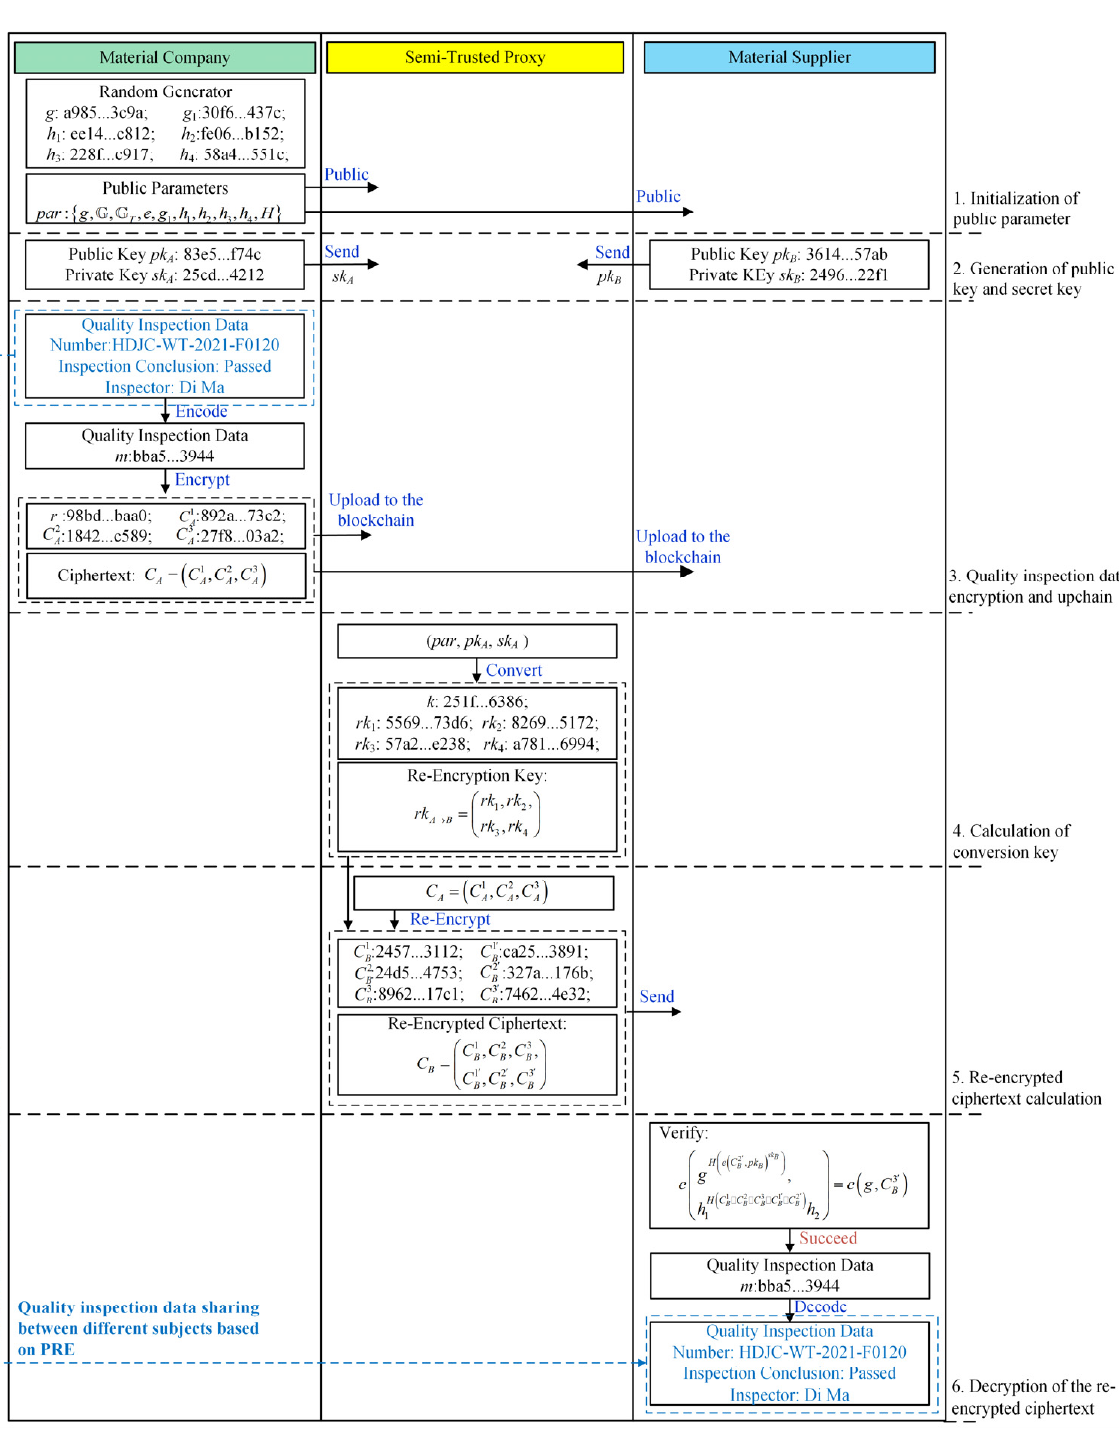
Figure 8. Power material data sharing process based on PRE.